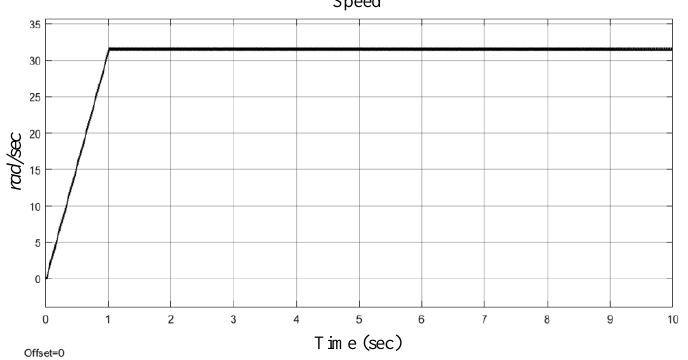
Figure 9. The simulated speed response of speed command of 31.4 rad/s.